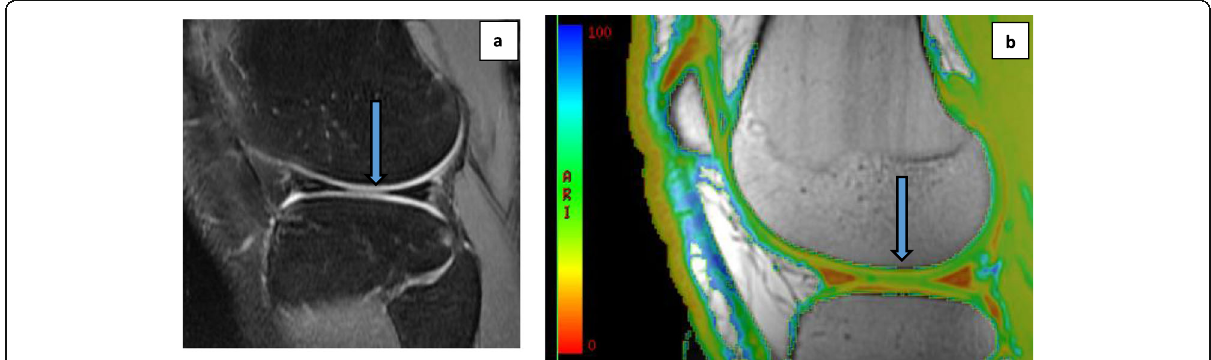
Fig. 2 Preserved bright hyper-intense signal of cartilage covering the lateral tibio-femoral condyle (arrow) ( a ) and normal color-coded values of cartilage (superficial and deep zones normal (red, yellow, or green)) covering the lateral tibiofemoral condyle ICRS grade 0 – 1(arrow) ( b